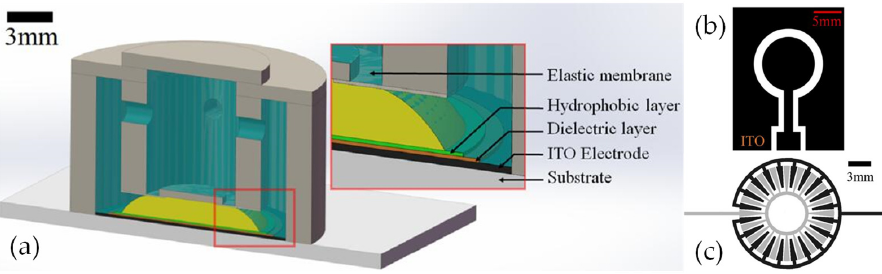
Figure 35. Phase modulator structure. ( a ) Cross-sectional view of the liquid phase modulator; the bottom electrode configuration: ( b ) key type; ( c ) interdigital type. Reprinted/adapted with permission from Ref. [142]. 2021 American Chemical Society.